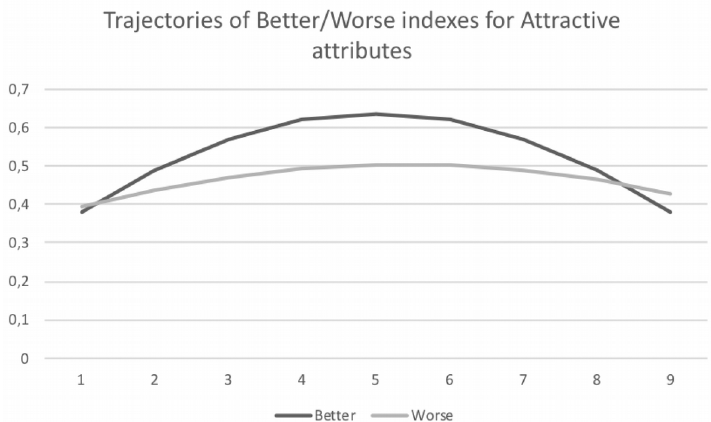
Figure 10. Expected trajectories of Better and Worse indexes for an attractive